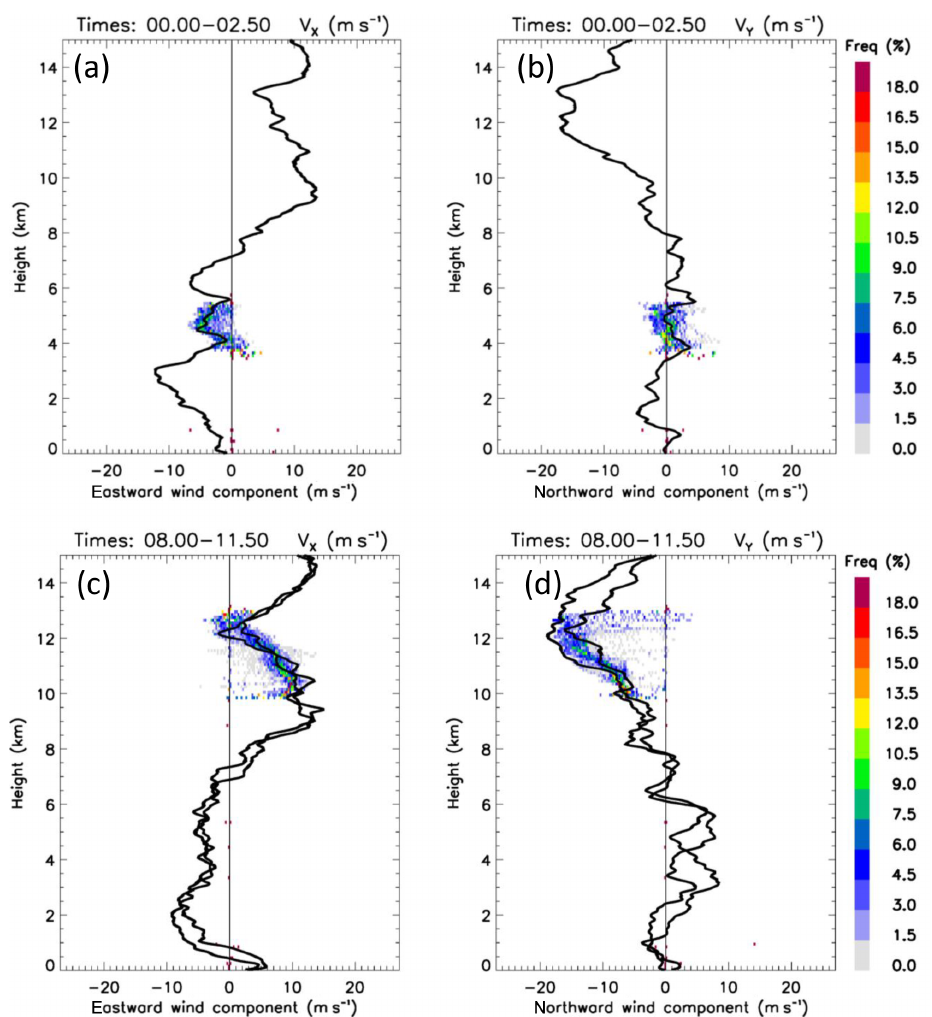
Figure 7. Same as Fig. 3 but for the (a, b) altostratus and (c, d) tropical cirrus cases sampled on 4 December